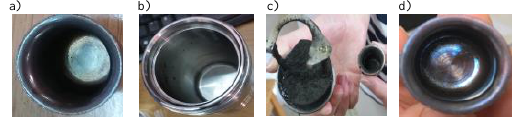
Fig. 4. Calorimetric bomb crucibles with residues of combustion products: a) MDO (Gdańsk University of Technology laboratory), b) RMD